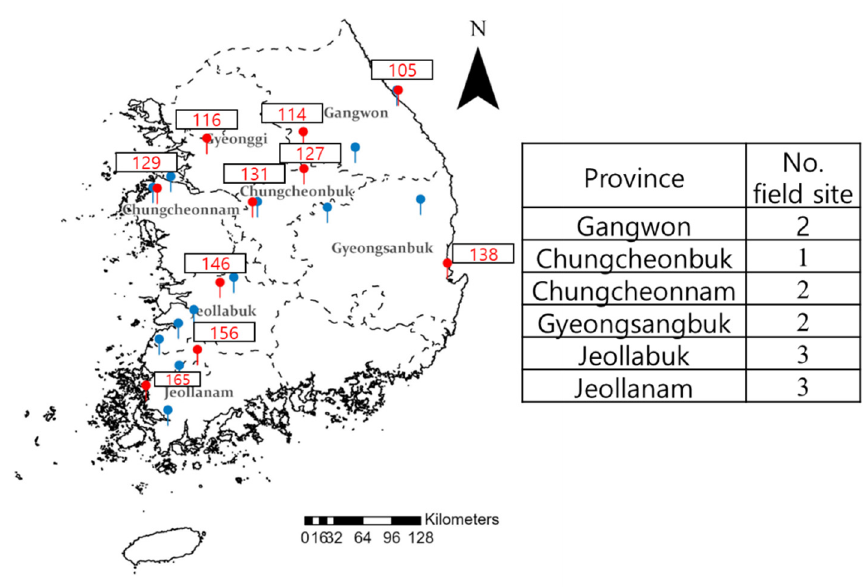
Figure 1. Field sites where the morphological characteristics of 24 different fall Chinese cabbage varieties were collected between 2020 and 2021 in six provinces in South Korea. The table shows the number of field sites within each province. Blue circles indicate the field site location in each province, and red circles indicate the simulation sites for the climate change study in Section 2.5. The number above each red circle indicates the weather station site ID.